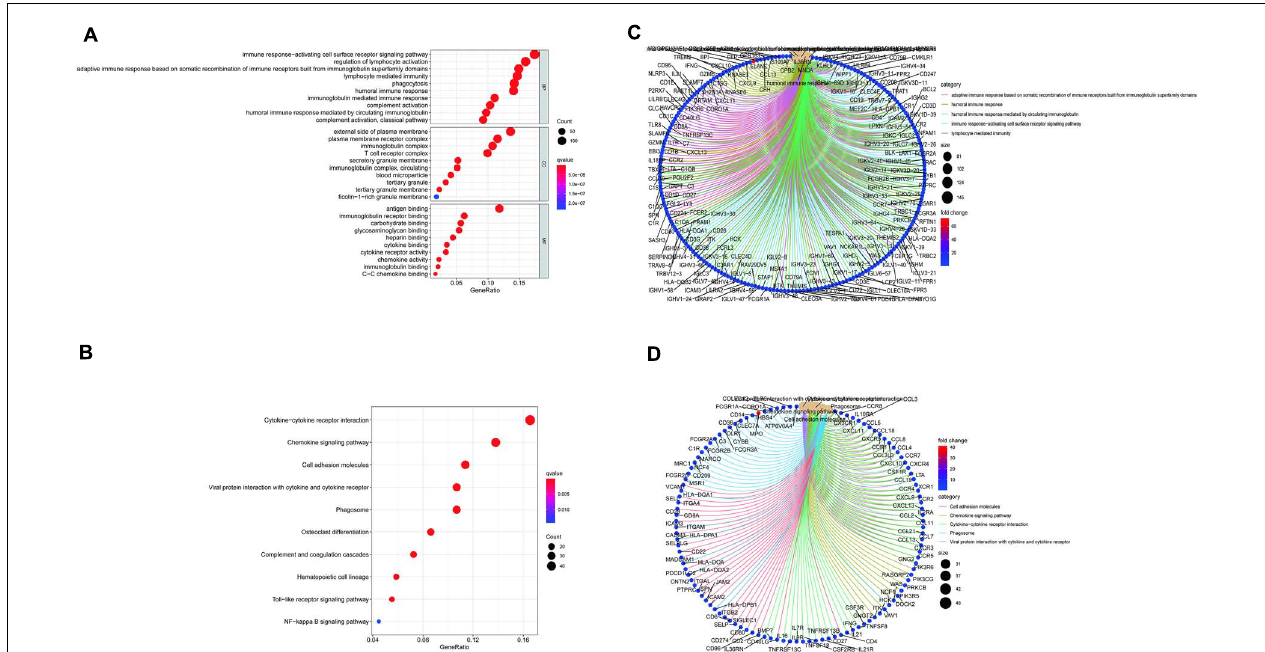
FIGURE 2 | Gene Ontology (GO) and Kyoto Encyclopedia of Genes and Genomes (KEGG) enrichment analysis of differentially expressed genes (DEGs) (A–D) .